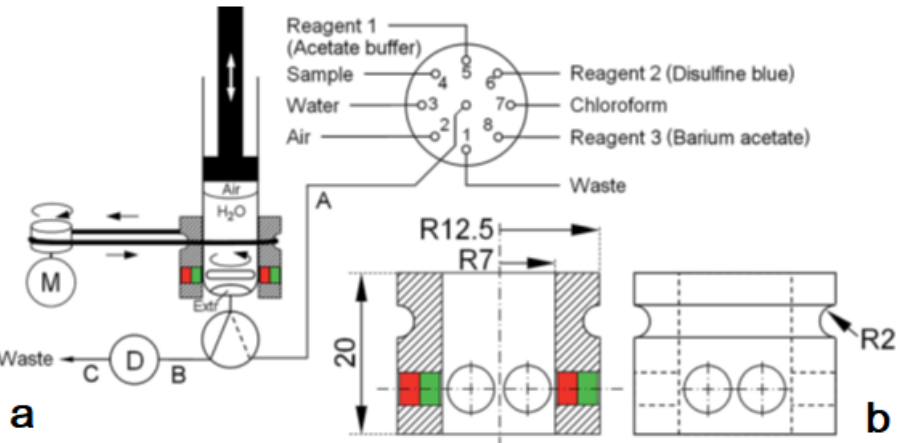
Figure 6. ( a ): analyzer manifold with the selection valve (SV), syringe (S), solenoid 3 ‐ way head valve (V), detection flow cell (D), and DC motor (M). PTFE tubing (0.8 mm id) A: 35 cm, B: 10 cm, and C: 40 cm.; ( b ): the magnetic stirring bar driver design given in detail consisting of a Delrin ®® tube and two neodymium magnets [37].